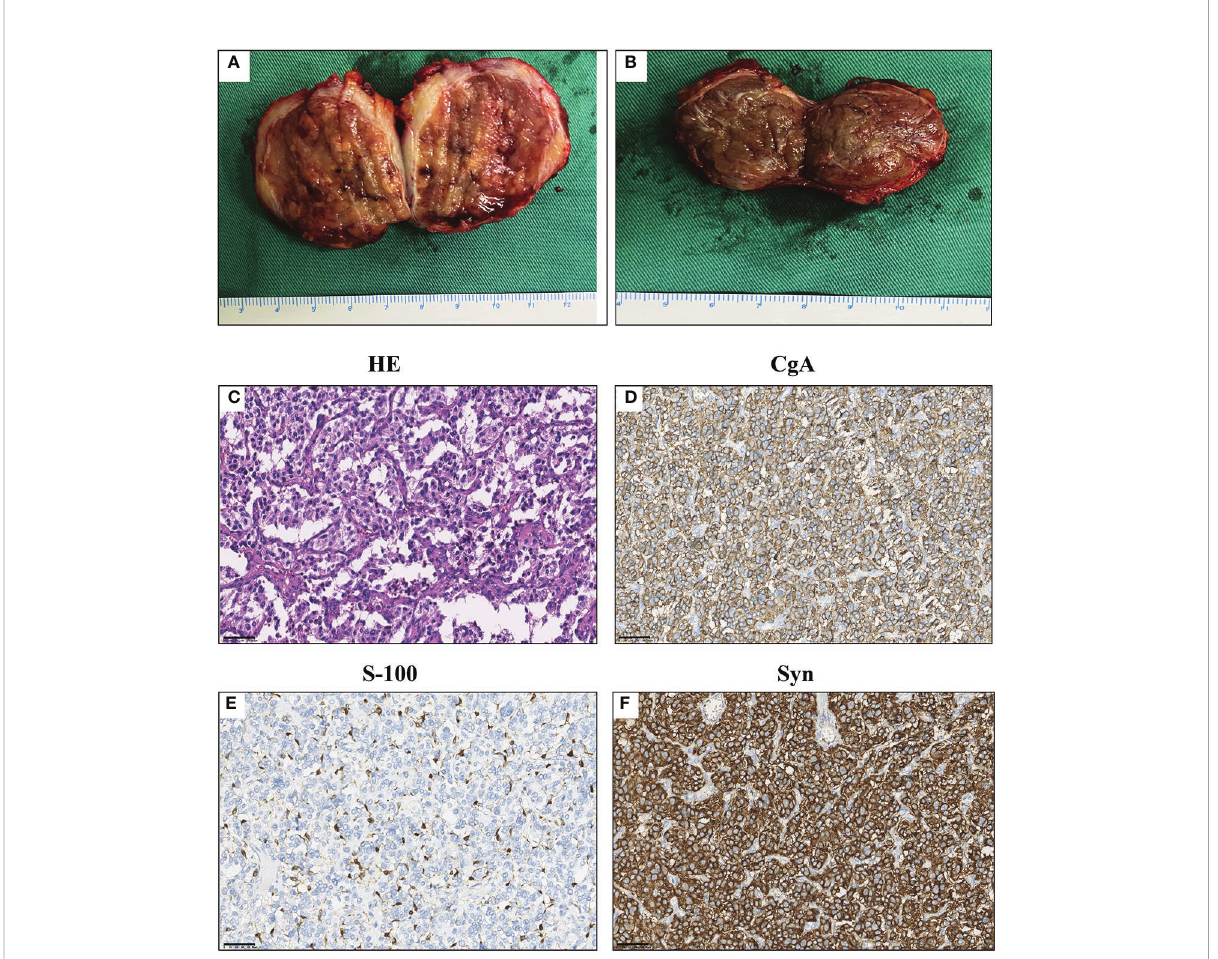
FIGURE 2 Macroscopic examination and immunochemistry results of the tumors. (A) Macroscopic examination of para-aortic PGL. (B) Macroscopic examination of para-vesical PGL. (C) HE staining of tumors. (D – F) Immunohistochemistry results of the tumors. Syn (+), CgA (+), S-100 (+), and the Ki-67 positive index was 1%. Scale bar = 50 m